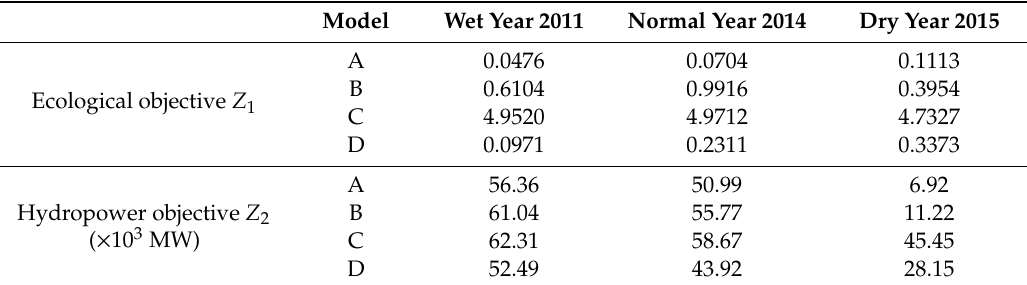
Table 3. Optimal objective values with di ff erent models.